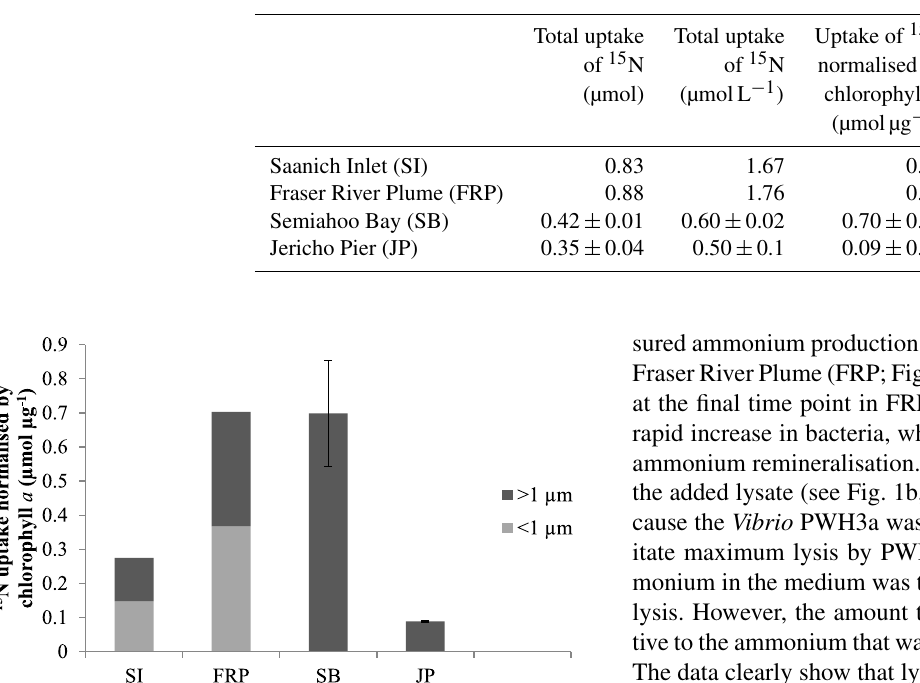
Table 4. Uptake by the particulate fraction of 15 N from bacterial lysate from four field stations, and the same uptake normalised by initial chlorophyll a concentrations. Error measurements are standard error of triplicate incubations for SB, and range of duplicate incubations for JP. SI and FRP are singleton measurements.